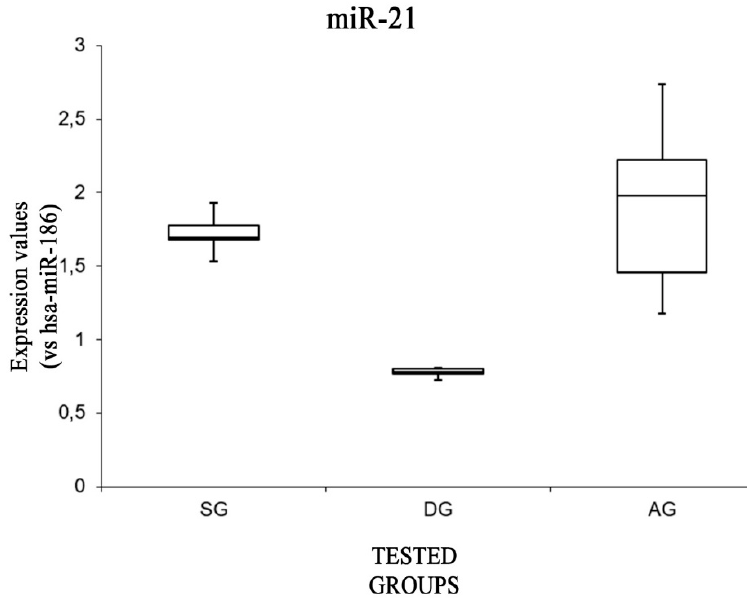
Figure 3. Box plot analysis showing the expression levels of miR-21 (endogenous control miR-186) in each group.